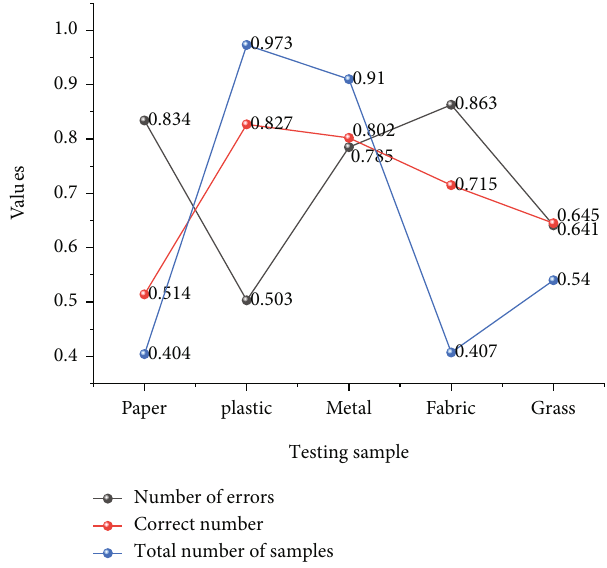
Figure 7: System classi fi cation test results.